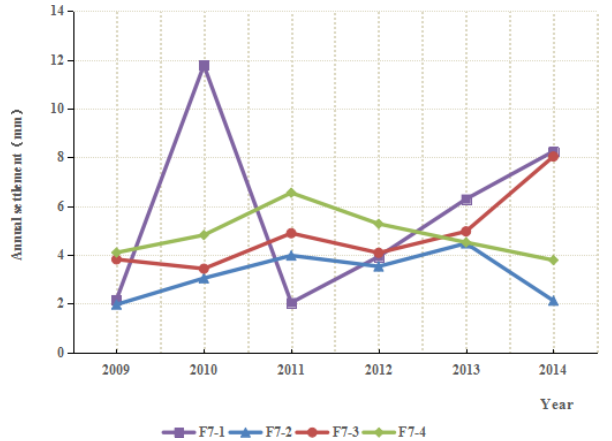
Figure 3. Annual settlement change curve of layerwise marks in the shallow layer (2009–2014).